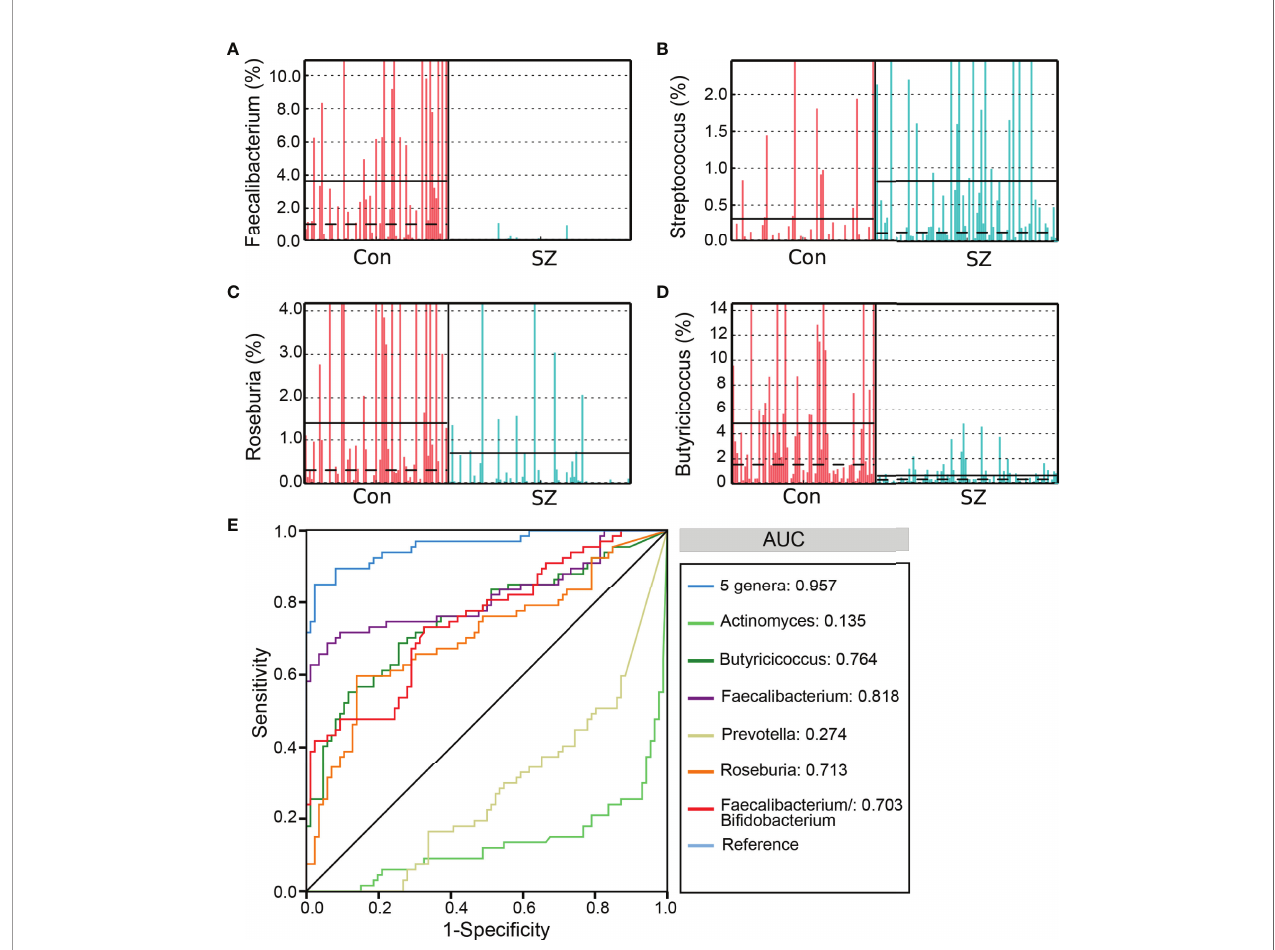
FIGURE 4 | The differential genera as SZ diagnostic markers. The relative abundance of the differential genera such as Faecalibacterium (A) , Streptococcus (B) , Roseburia (C) , and Butyricicoccus (D) in each sample. Receiver operating characteristic (ROC) curves for the differential genera alone or in combination, and Faecalibacterium/Bi fi dobacterium , used to discriminate SZ patients from healthy controls (E) . AUC, the area under the receiver operating characteristic